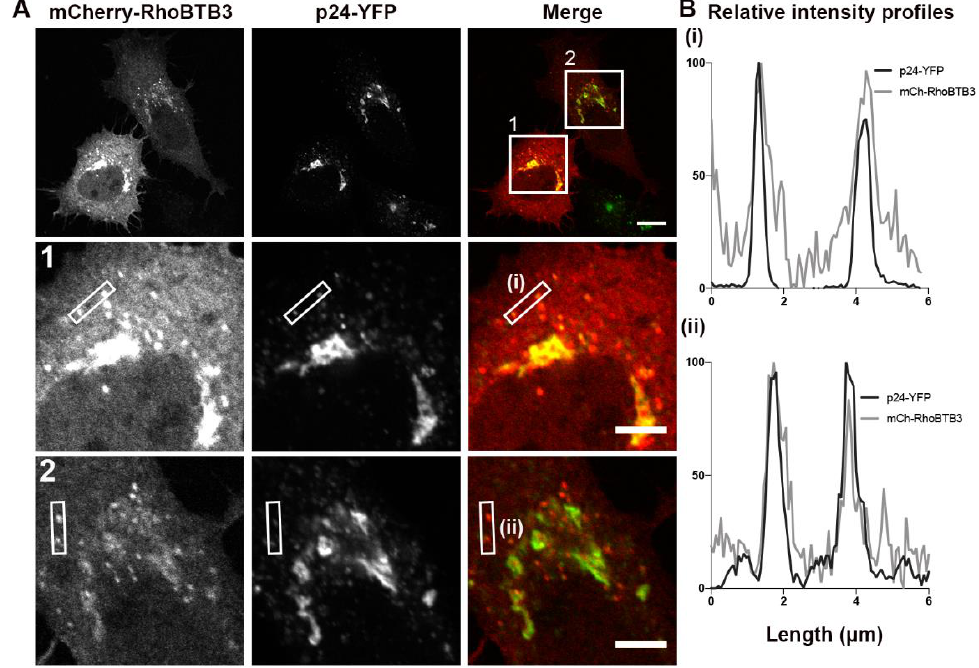
Figure 3. RhoBTB3 localises to transport carriers in the early secretory pathway. ( A ) HeLa cells stably expressing p24-YFP were transiently transfected with mCherry-RhoBTB3 for 18 h and imaged live. In the merge image, mCherry-RhoBTB3 is in red and p24-YFP in green. Bar represents 10 µ m. Squares 1 and 2 show zoomed images of two transfected cells. Bars represent 5 µ m. ( B ) Fluorescence intensity profiles of the areas marked by rectangles in A1 and A2, showing the correlation of mCherry-RhoBTB3 and p24-YFP signals.